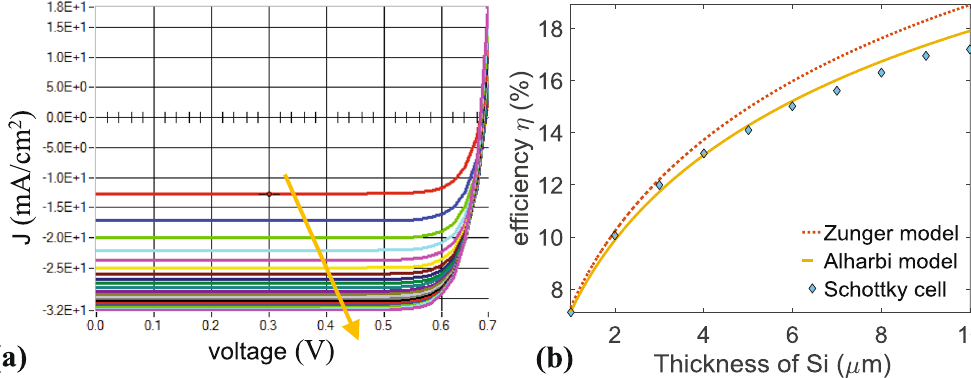
Figure 5. ( a ) Current-Voltage (J-V) curve for different thicknesses. The yellow arrow indicates increasing thickness of the Silicon layer (from 1 to 50 μ m) ( b ) Efficiency versus thickness of silicon layer deduced from the model of refs 38–40